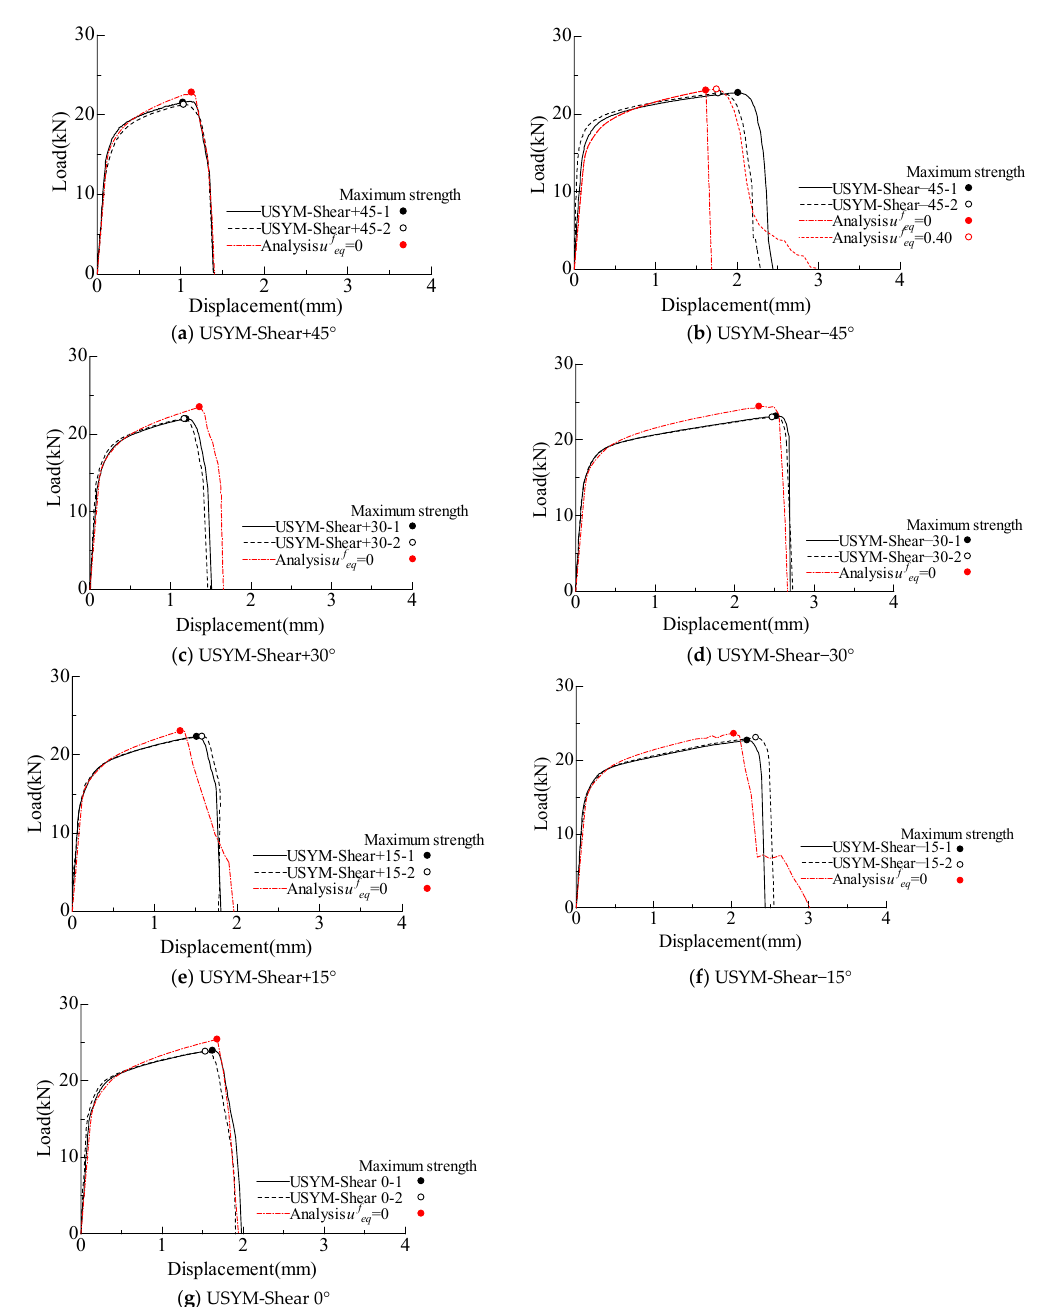
Figure 17. Comparison of experimental results and analysis results using the modified N-VG model (USYM-Shear specimens).